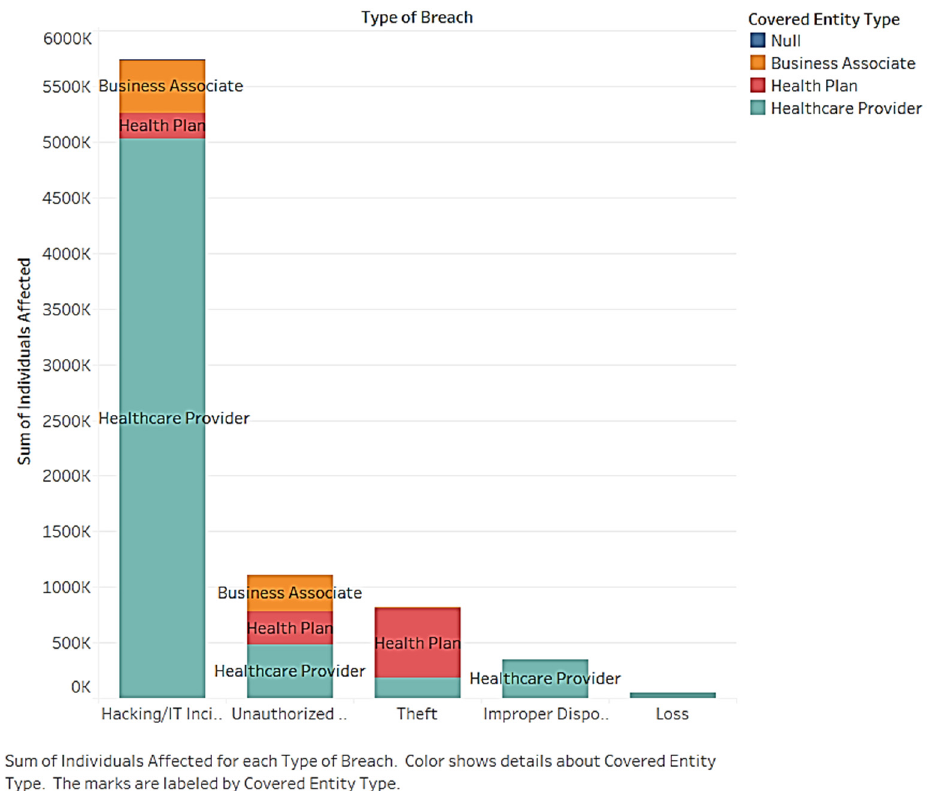
Figure 8. Distribution of affected individuals in data breach types and covered entity types.